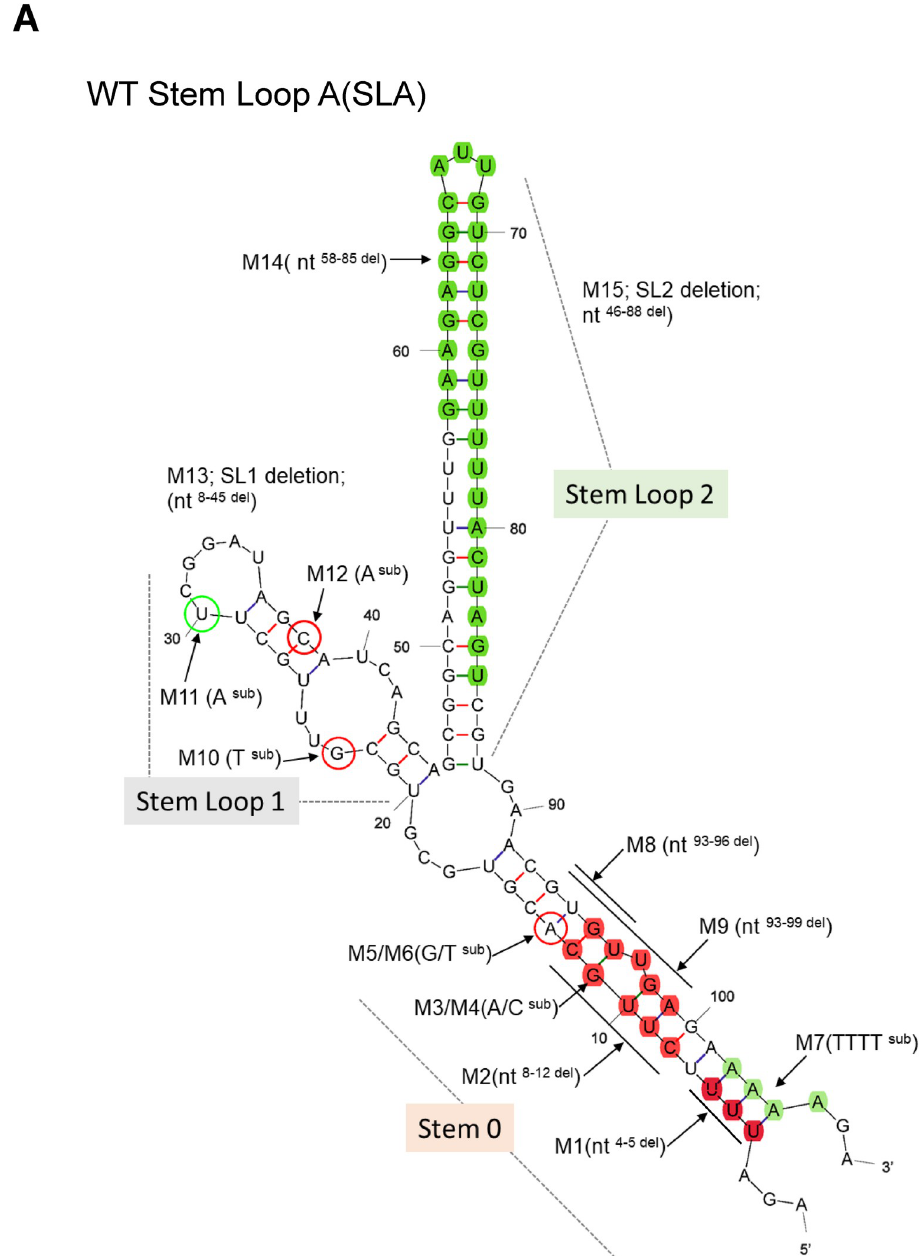
Fig 1. mFold structure of the 5 0 UTR of TBEV. ( A ) Computer-simulated predictions of WT TBEV with schematic representation of specific mutations within the SLA (arrows). Single nucleotide changes for M3-M6 and M12 (non- infectious) are circled in red. M11 (infectious) is in green. Double loop deletions (M16-M18) are not shown. Proposed sequence elements within Stem-Loop A (SLA) are labelled. Each deleted region is depicted by a solid line. Non-lethal mutants are highlighted in green. The first 107 nucleotides of the WT (GenBank accession: AF069066) region was assessed using Mfold (available on http://www.unafold.org/mfold/applications/rna-folding-form.php).